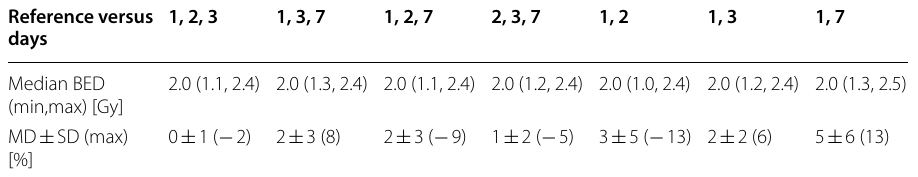
Table 4 Resulting median kidney BEDs and mean deviations from the reference model for the different time samplings. The median BED 2.4